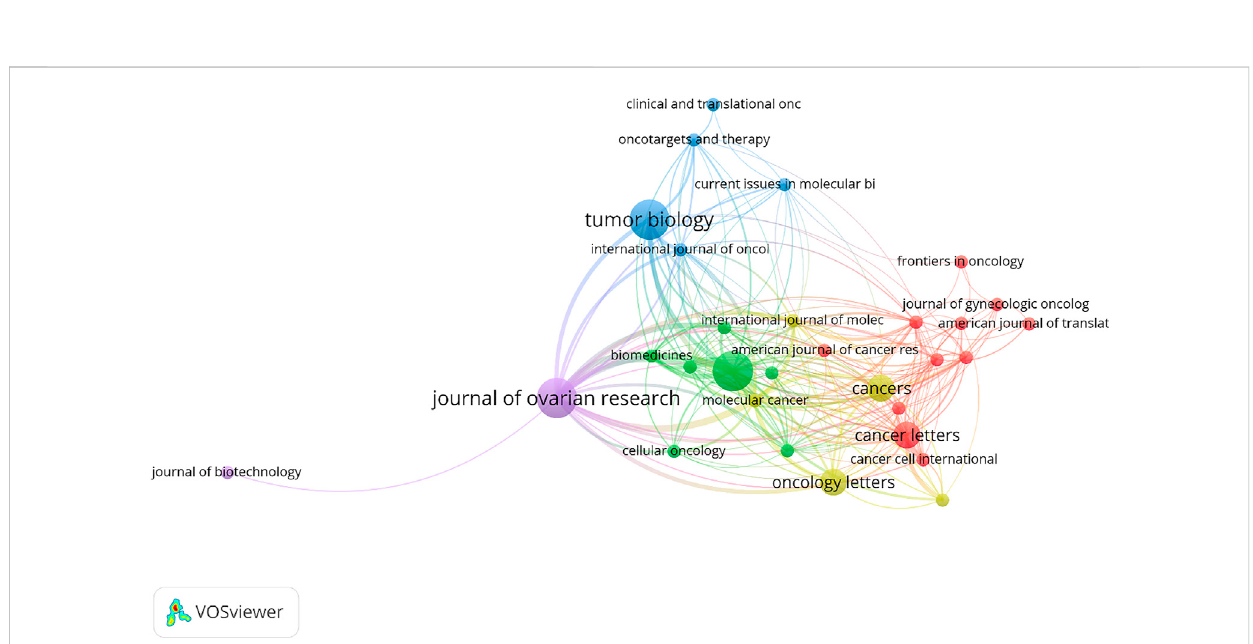
FIGURE 9 Bibliographic coupling of journals (criteria: journals with at least one article in the fi eld of exosome and OEC).